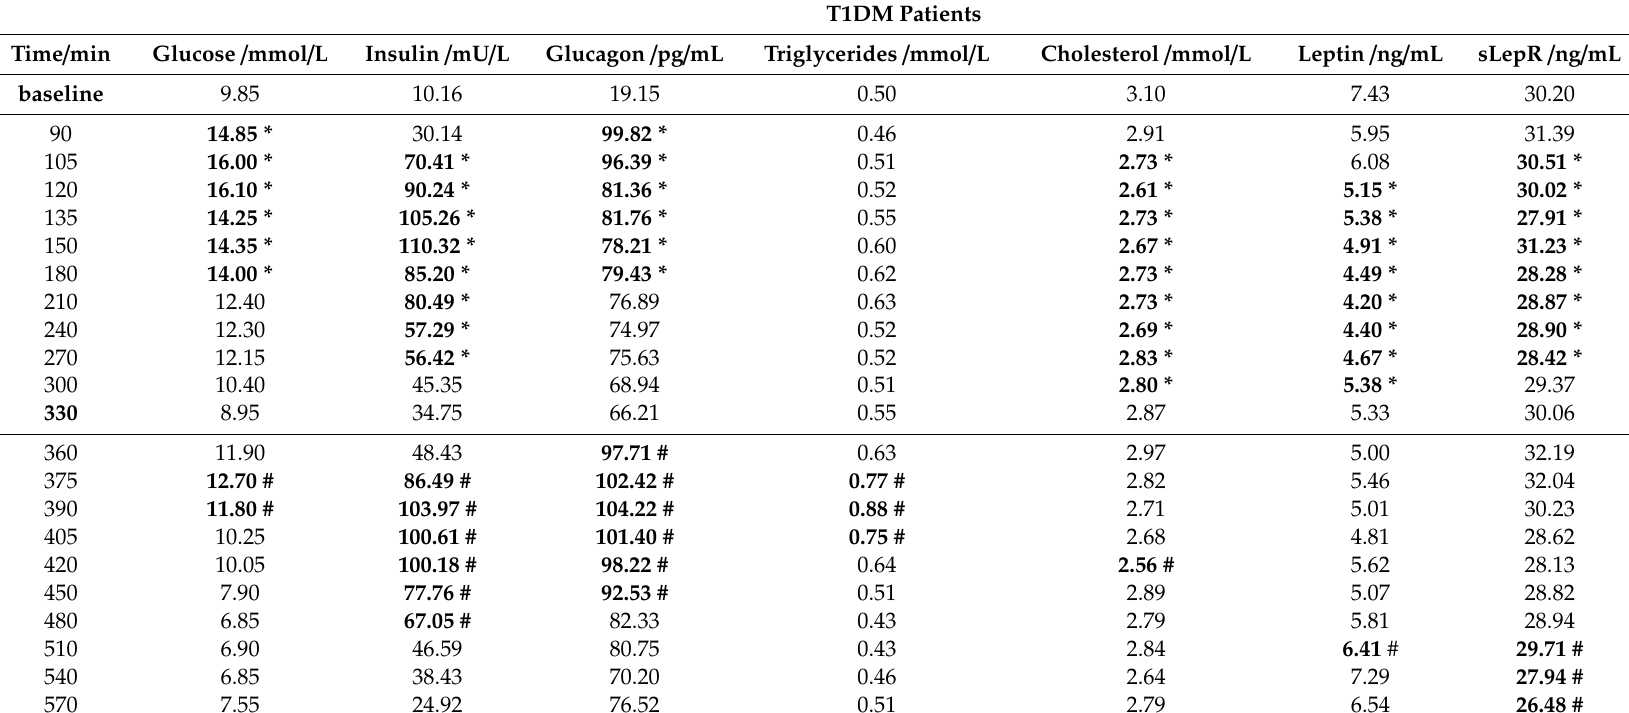
Table 2. Time resolved analysis of the changes in serum concentrations. Per group and parameter, data for median is given, and significant changes (repeated measurement ANOVA on ranks in combination with Dunn’s method for pair-wise multiple comparisons versus control), are marked in bold and with an asterisk or hash, respectively. Significant changes in the first half of the experiment versus baseline (min 60, immediately before breakfast) is marked with an asterisk (*) and significant changes in the second half of the experiment versus minute 330 (immediately before lunch) are marked with a hash (#). P -values of 0.05 or lower were considered as